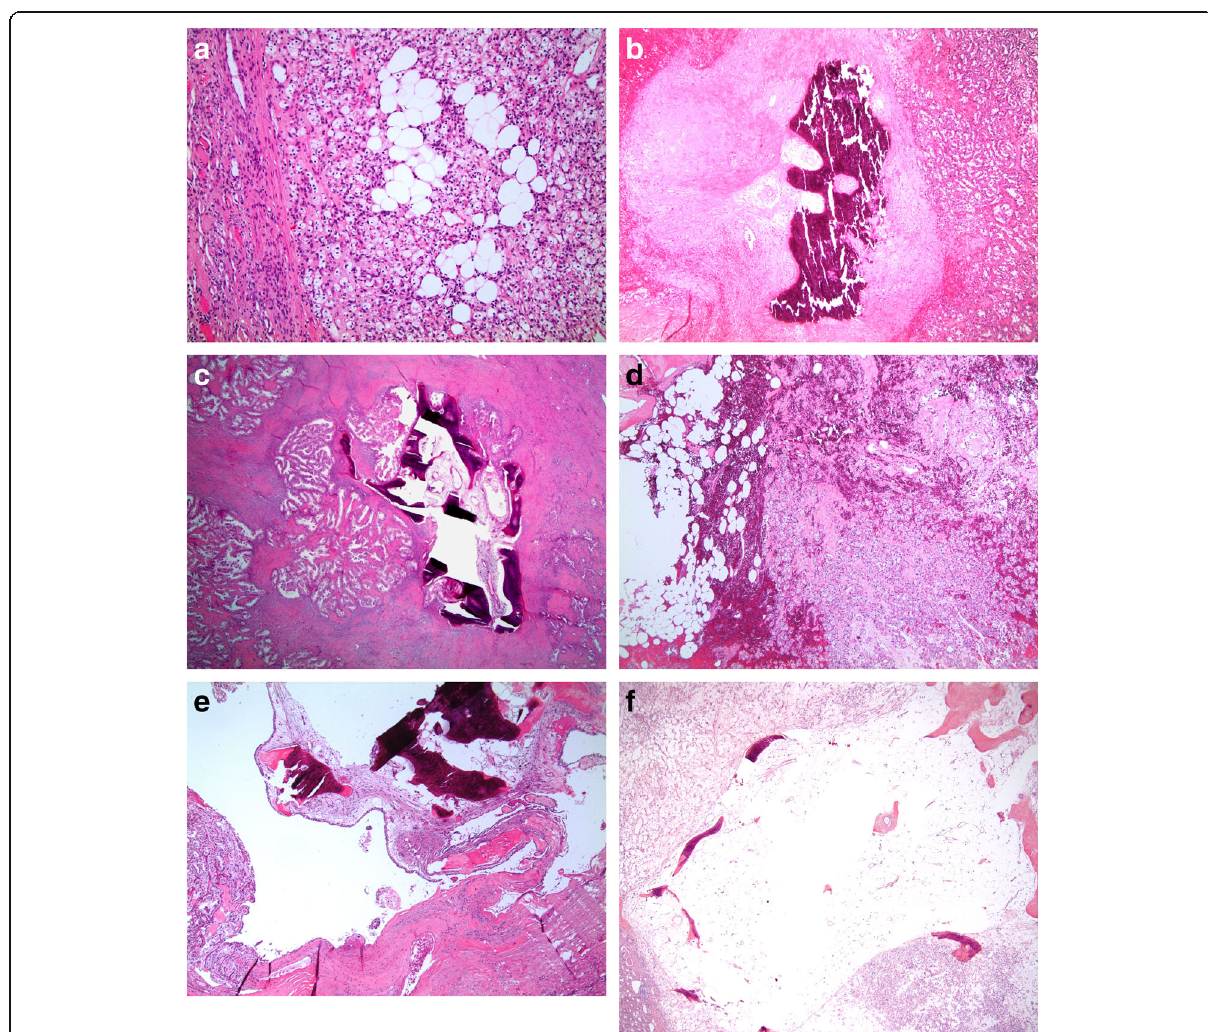
Fig. 1 Photomicrographs of renal cell carcinoma (RCC) with adipose and/or osseous metaplasia. a, RCC, clear cell type with a minute (0.1cm) deposit of adipose metaplasia near the tumor edge (Case 14 on Table 2) (10X magnification). b, RCC, papillary type I with osseous metaplasia consisting of mostly bone and only rare adipocytes (Case 11 on Table 2) (4X magnification). c , RCC with leiomyomatous-like stroma containing a focus of osseous metaplasia with occasional adipocytes (Case 12 on Table 2) (2X magnification). d , RCC, chromophobe type with adipose metaplastic deposit located centrally within the tumor (Case 17 on Table 2) (4X magnification). e, RCC, clear cell papillary type with osseous metaplasia containing adipose adjacent to the tumor capsule (Case 10 on Table 2) (2X magnification). f, RCC, clear cell type with osseous metaplasia consisting of predominantly adipocytes abutting the tumor edge, AML was considered in the radiologic differential diagnosis for this case (Case 1 on Table 2) (4X